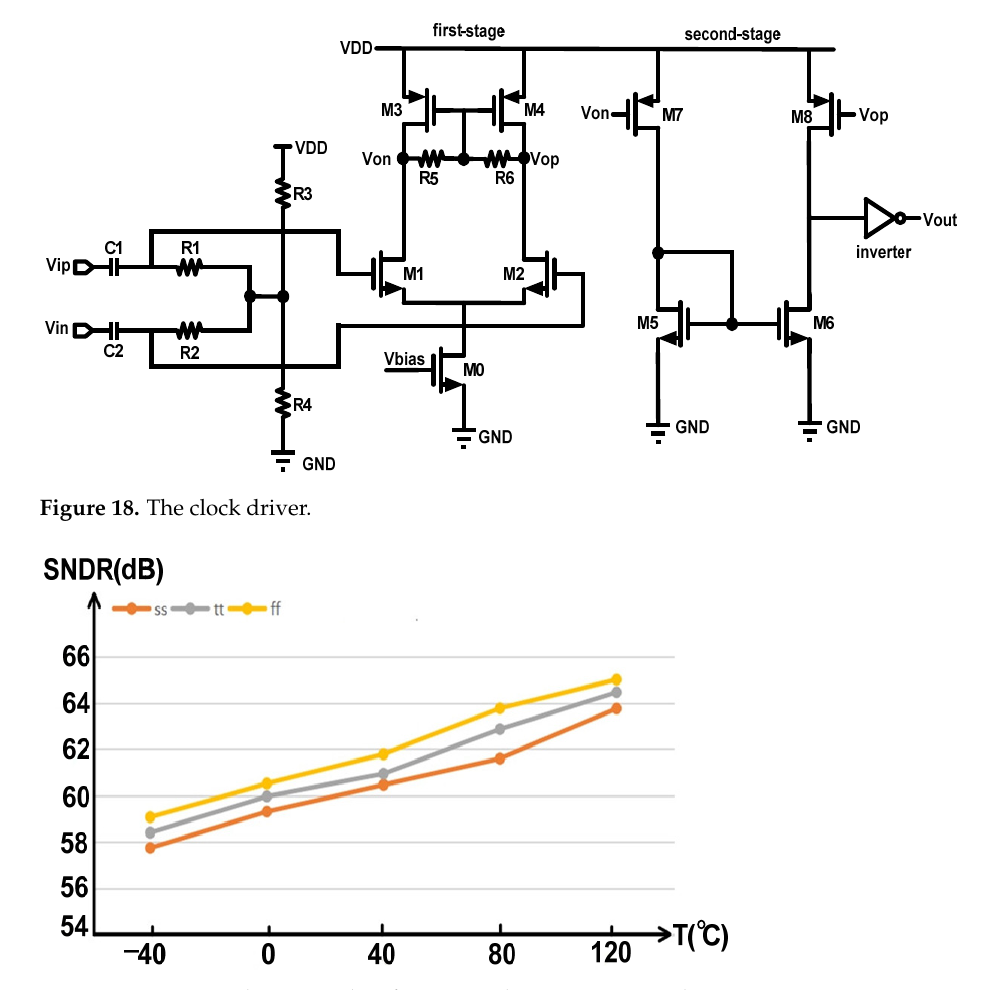
Figure 19. Post simulation results of SNDR with temperature and corner .